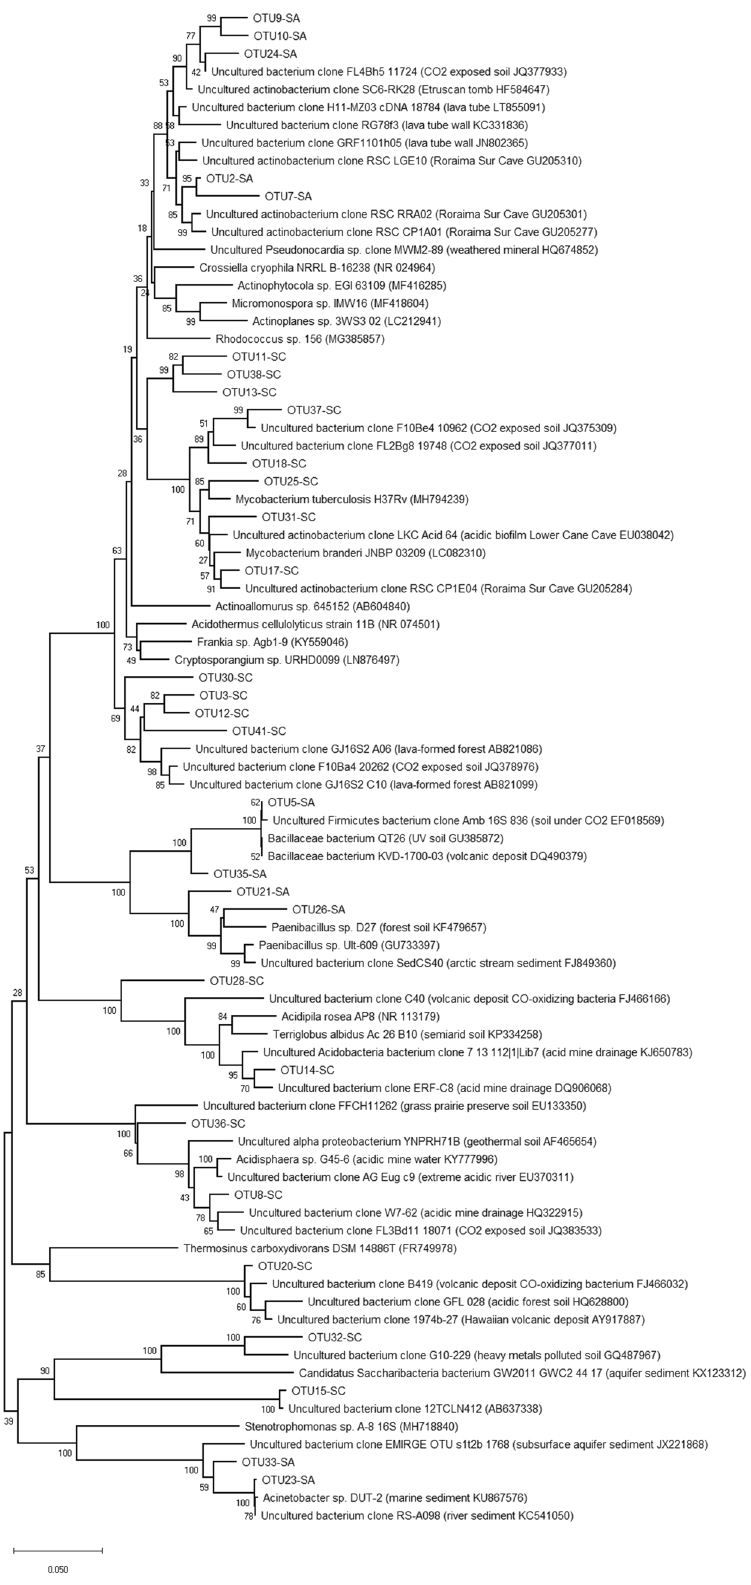
Figure 5. Neighbour-joining tree showing the phylogenetic affiliation of the dominant bacterial OTUs (named “OTU#”) in the samples SA and SC. Bootstrap values (based on 1000 replications) are shown at branch points. Bar, 0.05 substitutions per nucleotide